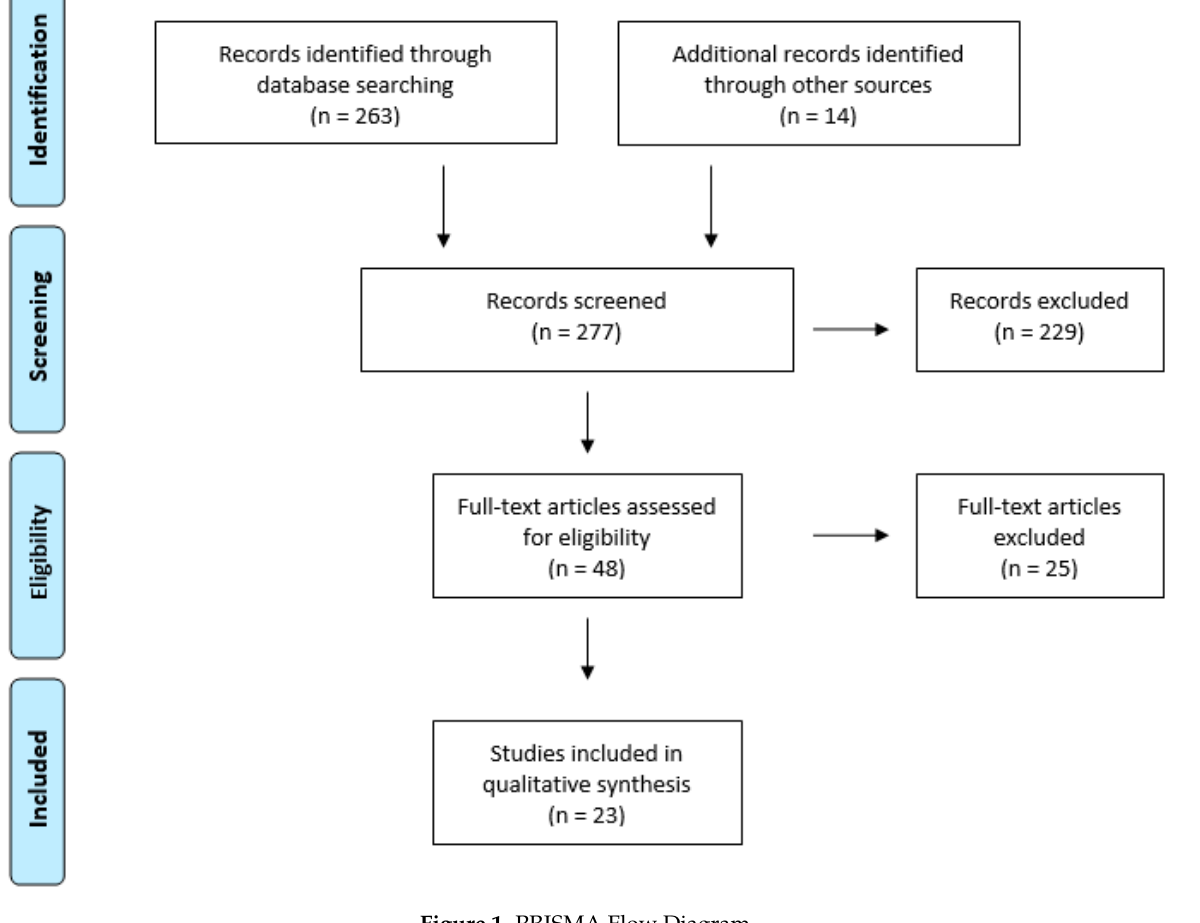
Figure 1. PRISMA Flow Diagram.